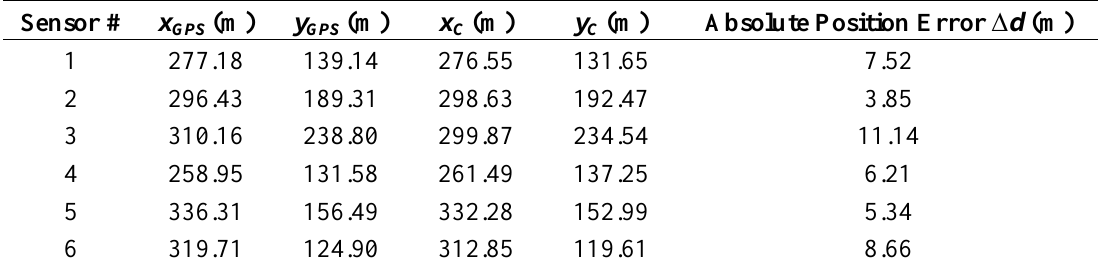
Figure 8. Reference points angles measurement for S